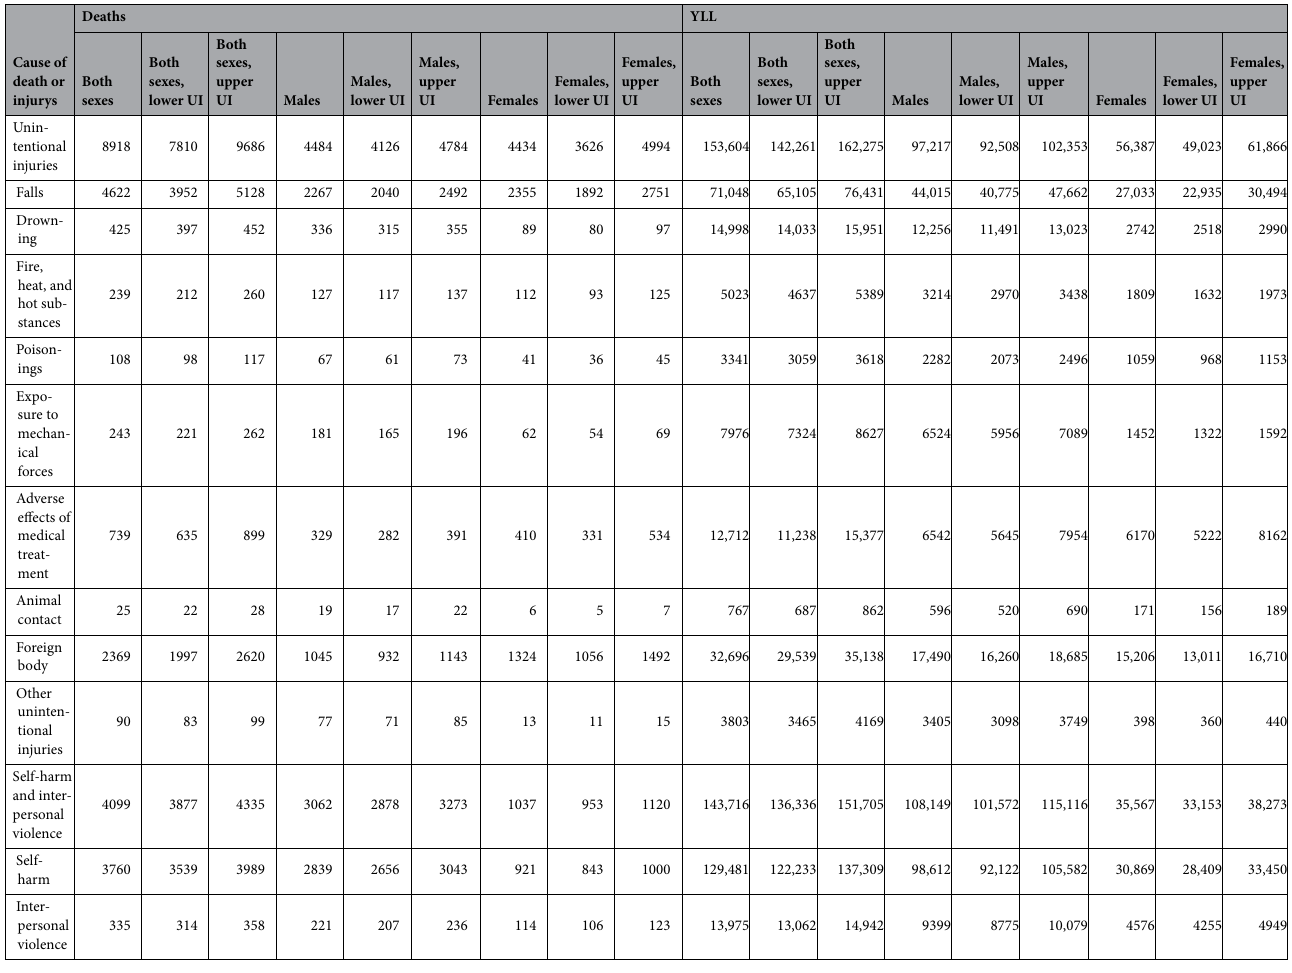
Table 1. Causes of death and years of life lost (YLLs) in all ages, by sex, in Spain in